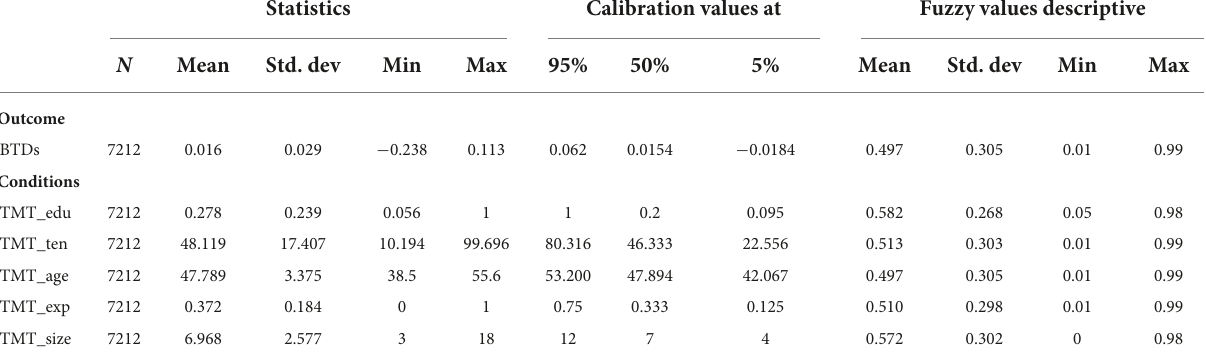
TABLE 2 Calibration values and statistics.